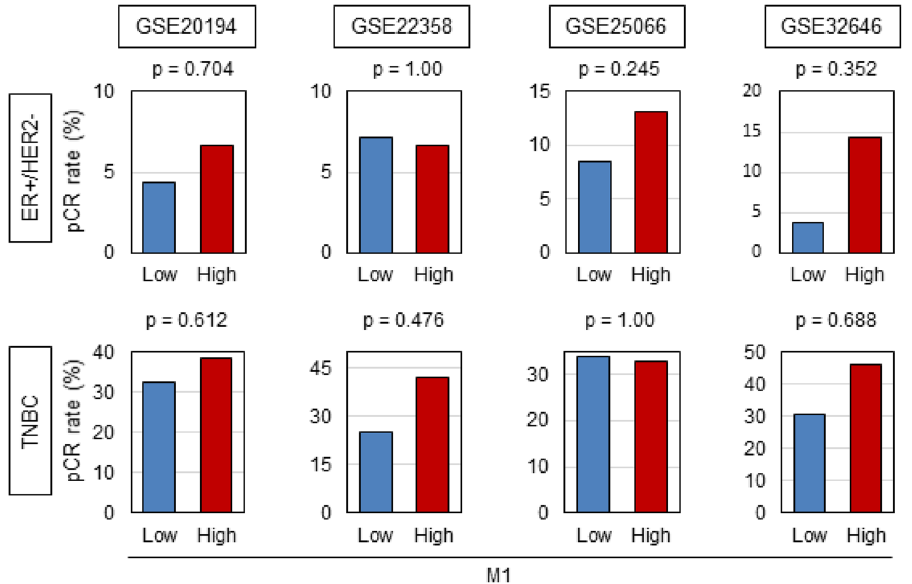
Figure 2. “M1” high tumors did not demonstrate the association with response to neoadjuvant chemotherapy. The association between expression of “M1” and pCR rate. GSE20194 (ER+/HER2−, n = 129, High = 60, Low = 69; TNBC, n = 68, High = 34, Low = 34). GSE22358 (ER+/HER2−, n = 67, High = 34, Low = 33; TNBC, n = 50, High = 25, Low = 25). GSE25066 (ER+/HER2−, n = 289, High = 145, Low = 144; TNBC, n = 178, High = 90,